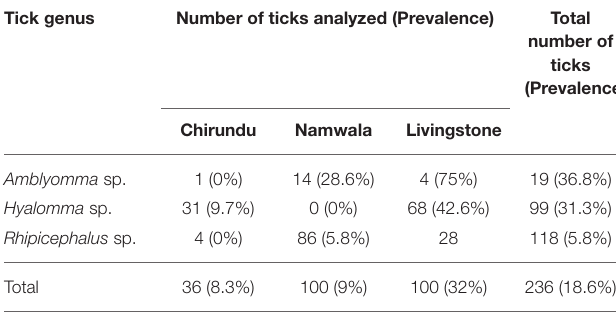
TABLE 1 | Number of ticks collected and the prevalence of infection in the different sampling areas by genus. Tick genus Number of ticks analyzed